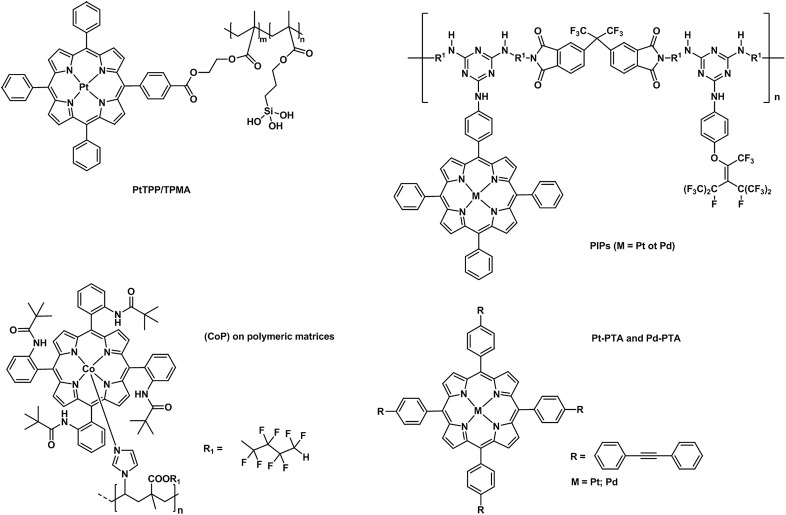
Different examples of metallaporphyrins supported in polymeric matrices (PtTPP/TPMA Mao, Y. et al., 2017, PIPs (Kimura et al., 2017), CoP (Röösli et al., 1997), Pt/Pd-PTA (Önal et al., 2016) applied in the sensing of molecular oxygen.